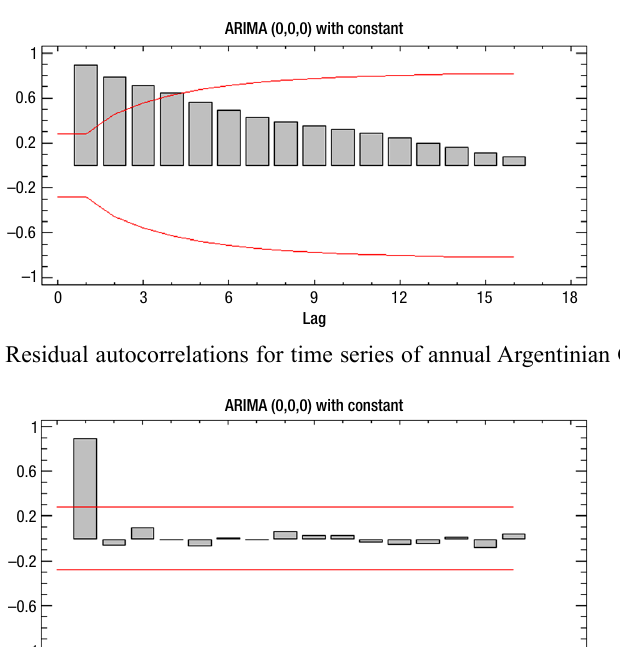
Fig. 12. Time sequence plot for time series of annual Argentinian GDP